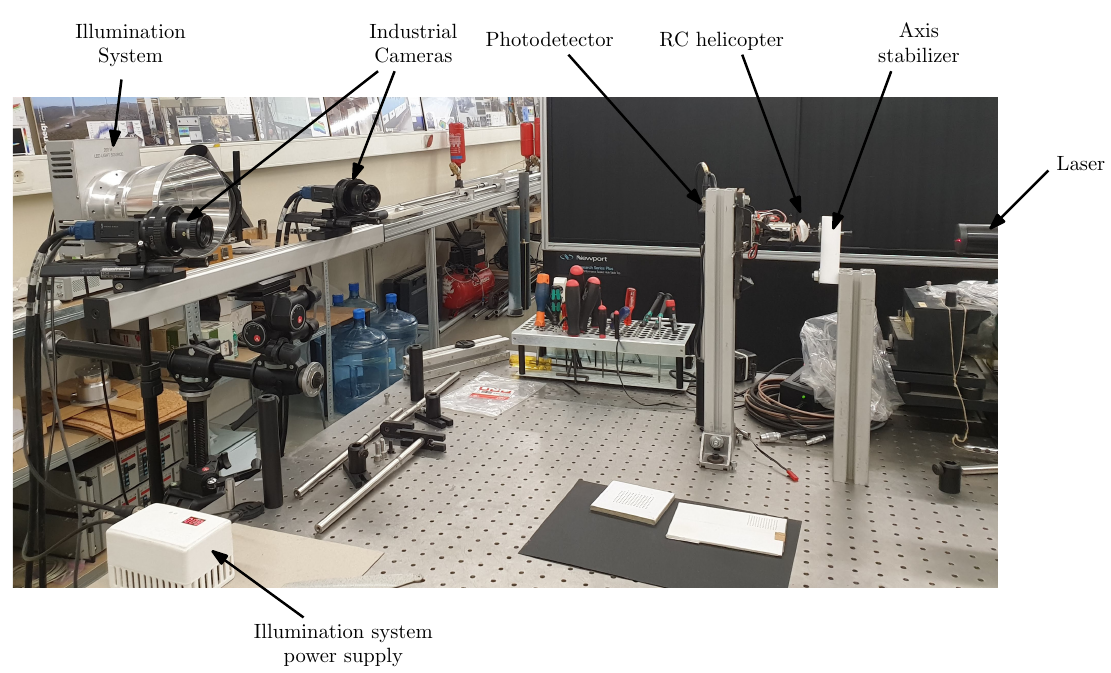
Figure 1. Experimental setup for the new image sensing methodology.